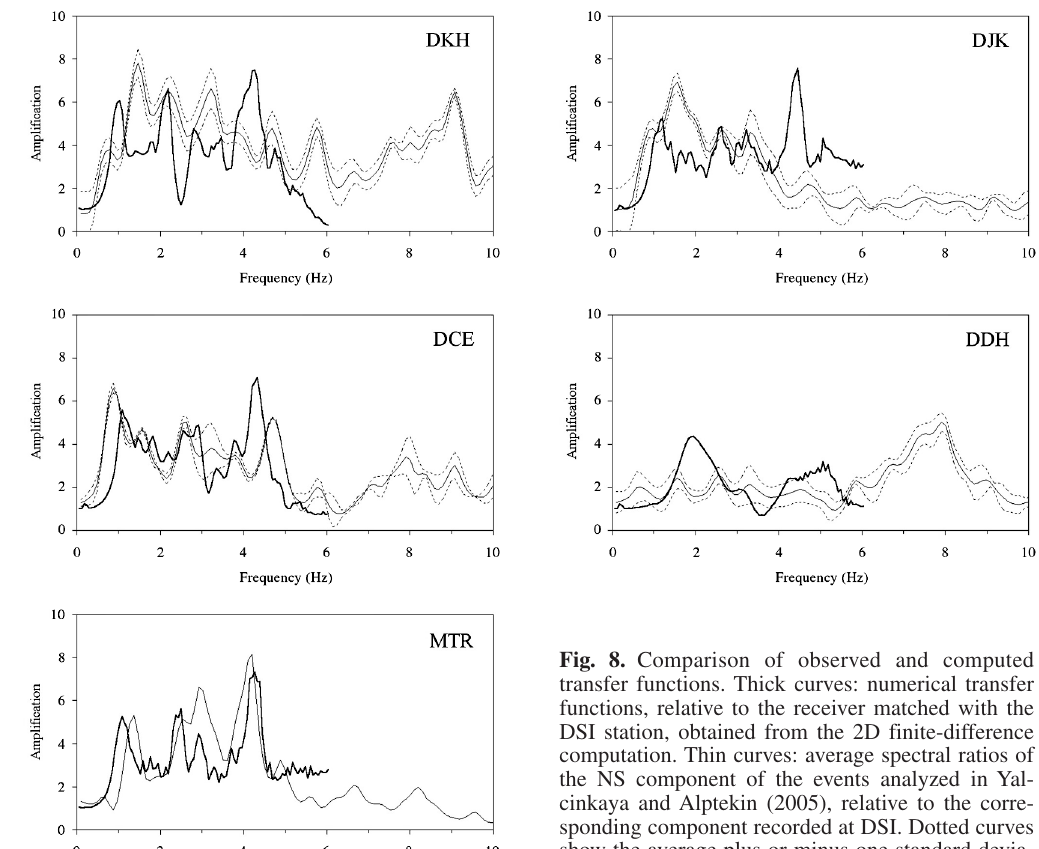
Fig. 8. Comparison of observed and computed transfer functions. Thick curves: numerical transfer functions, relative to the receiver matched with the DSI station, obtained from the 2D finite-difference computation. Thin curves: average spectral ratios of the NS component of the events analyzed in Yal- cinkaya and Alptekin (2005), relative to the corre- sponding component recorded at DSI. Dotted curves show the average plus or minus one standard devia-